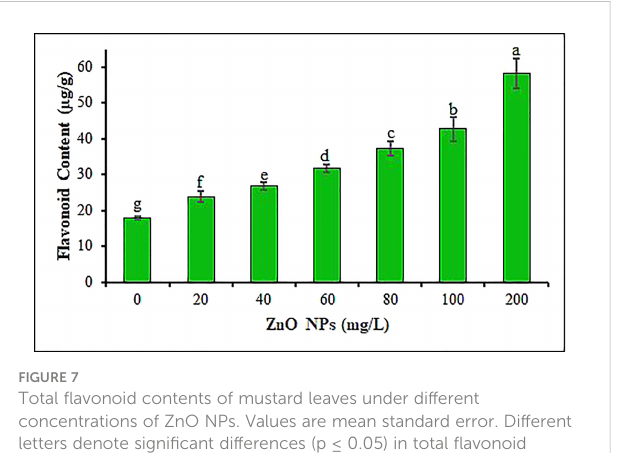
FIGURE 7 Total fl avonoid contents of mustard leaves under different concentrations of ZnO NPs. Values are mean standard error. Different letters denote signi fi cant differences (p ≤ 0.05) in total fl avonoid content among ZnO NPs concentrations.